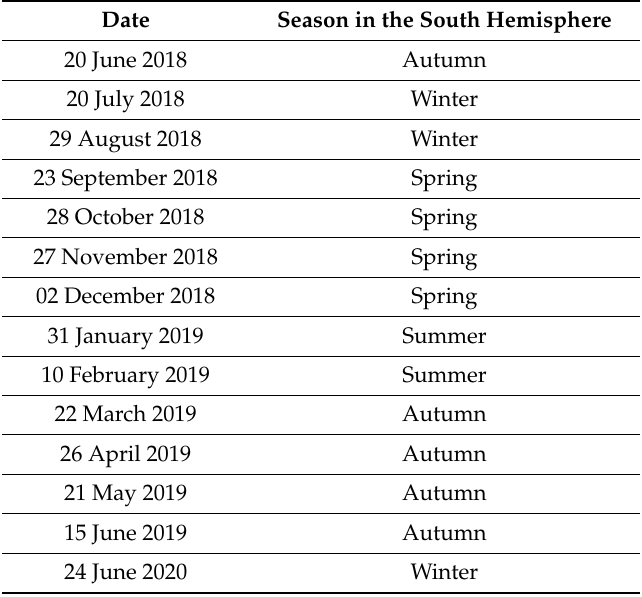
Table 1. Information regarding the 14 Sentinel-2 images used in this